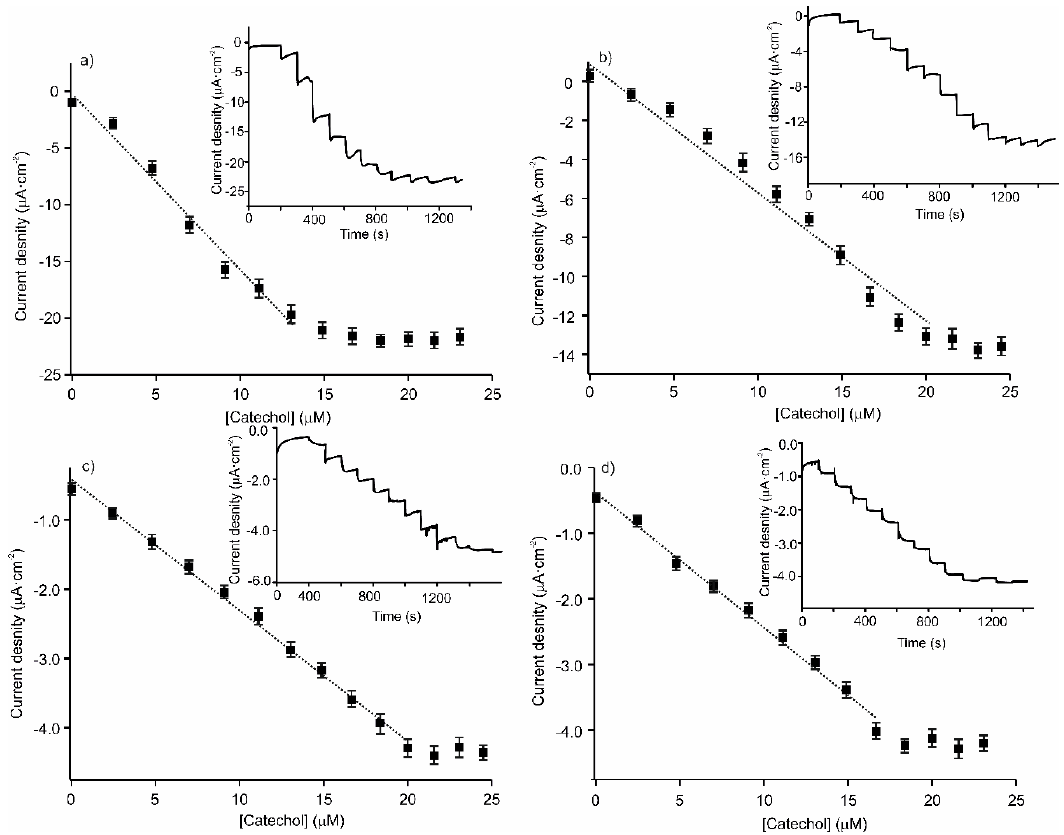
Figure 5. Calibration curves of the amperometric response for increasing the concentration of catechol at ( a ) [(CHI)-(CuPcS)-(CHI)-(AuNPs)] 2 -Tyr; ( b ) [(CHI)-(AuNPs)-(CHI)-(CuPcS)] 2 -Tyr; ( c ) [(CHI)- (CuPcS)-(CHI)-(AuNPs)] 2 -Lac; and d) [(CHI)-(AuNPs)-(CHI)-(CuPcS)] 2 -Lac. The insets show the ( c ) [(CHI)-(CuPcS)-(CHI)-(AuNPs)] 2 -Lac; and ( d ) [(CHI)-(AuNPs)-(CHI)-(CuPcS)] 2 -Lac. The insets amperometric responses obtained for each biosensor. show the amperometric responses obtained for each